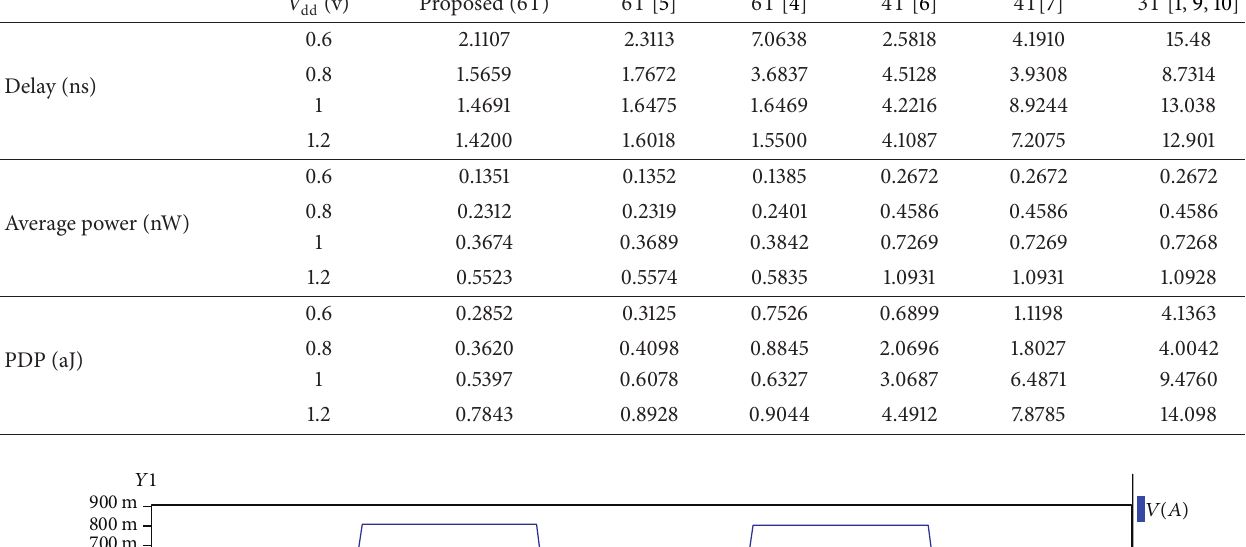
Table 1: Comparison of the simulation results for different CMOS XOR gates with the proposed XOR gate.